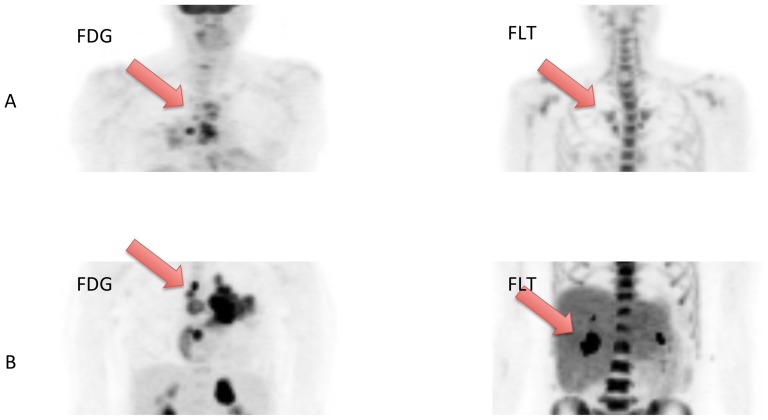
Example of two patients with low and high baseline uptake of FDG and FLT.The patient shown in figure A with low uptake is a 66-year old female patient who had an overall survival of 21.3 months, whereas the patient in B with a high uptake is a 56-year old female patient with an overall survival of only 1.5 months. In both cases, the respective most active lesion was chosen for assessment.